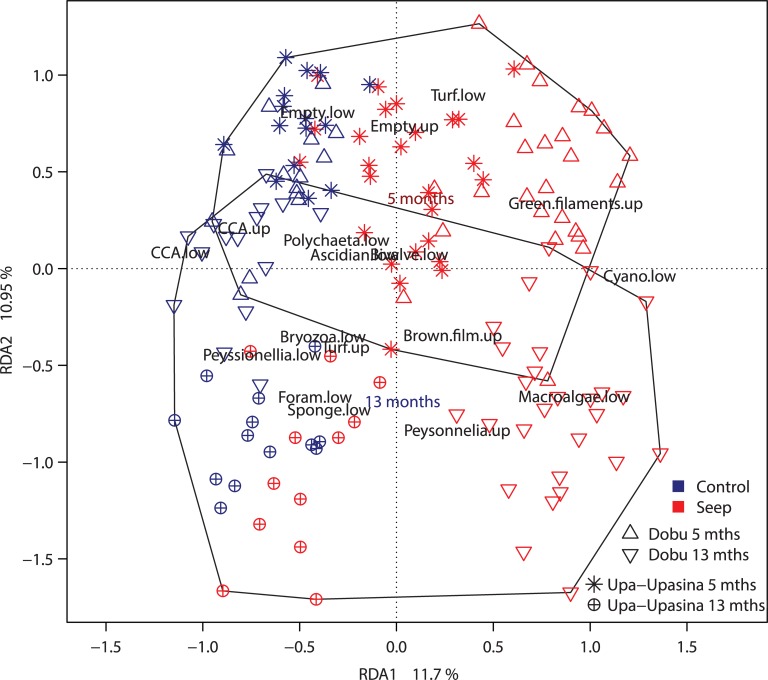
Redundancy analysis ordination of the settlement tile benthic communities at the seep and control sites.Red points represent tiles from the seeps, and blue from the controls, of Dobu and Upa-Upasina Reefs. Points in the upper polygon are five month (mths) old communities, while those in the lower polygon are at 13 months.